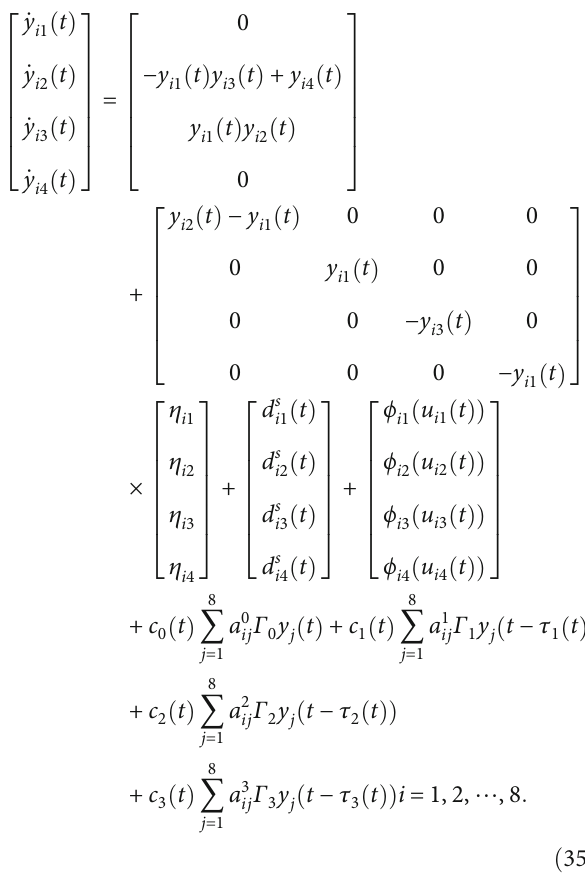
and h ð t Þ x 4 i 4 i